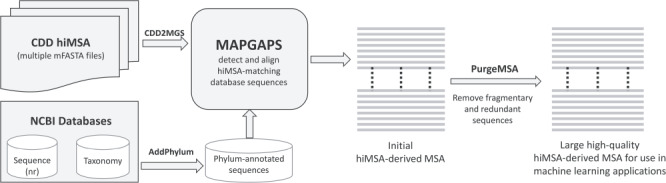
Steps required to create a large, high-quality MSA using the CDD hiMSAs and programs described here.